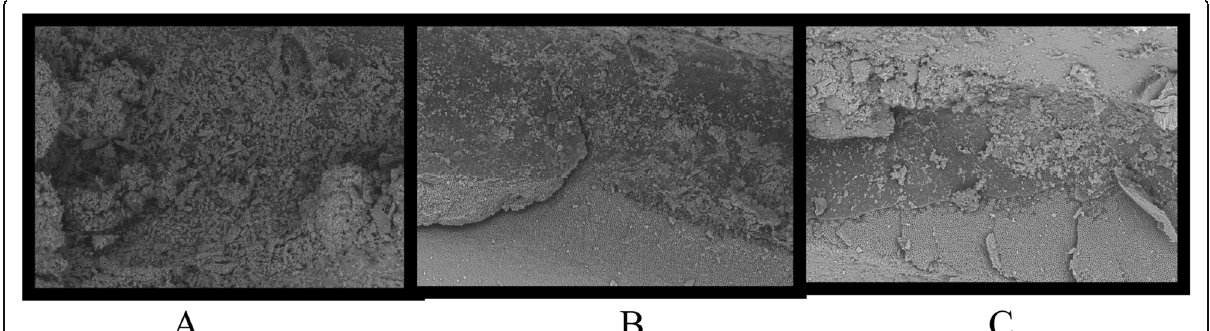
Fig. 8 SEM images of group 3. a Coronal. b Middle. c Apical